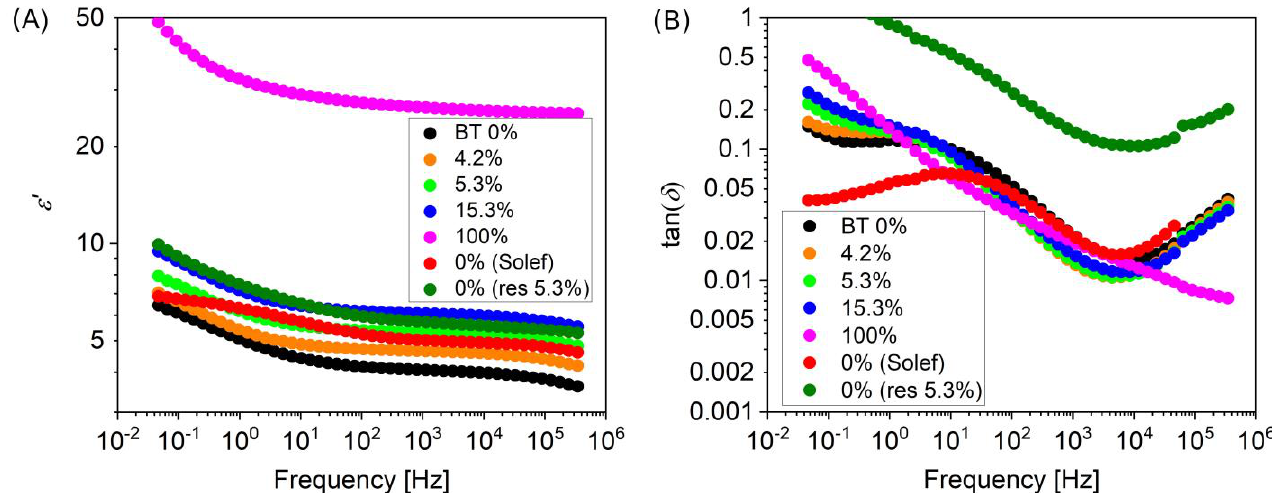
Figure 2. Frequency dependence of the dielectric constant ( A ) and loss tangent ( B ) of RAFT PVDF, PVDF- g -BT nanocomposites with the three different volume fractions of BT, the residual ungrafted PVDF extracted from the 5.3 vol% nanocomposite, the Solef PVDF, and the as-received BT nanoparticles, at 20 °C.